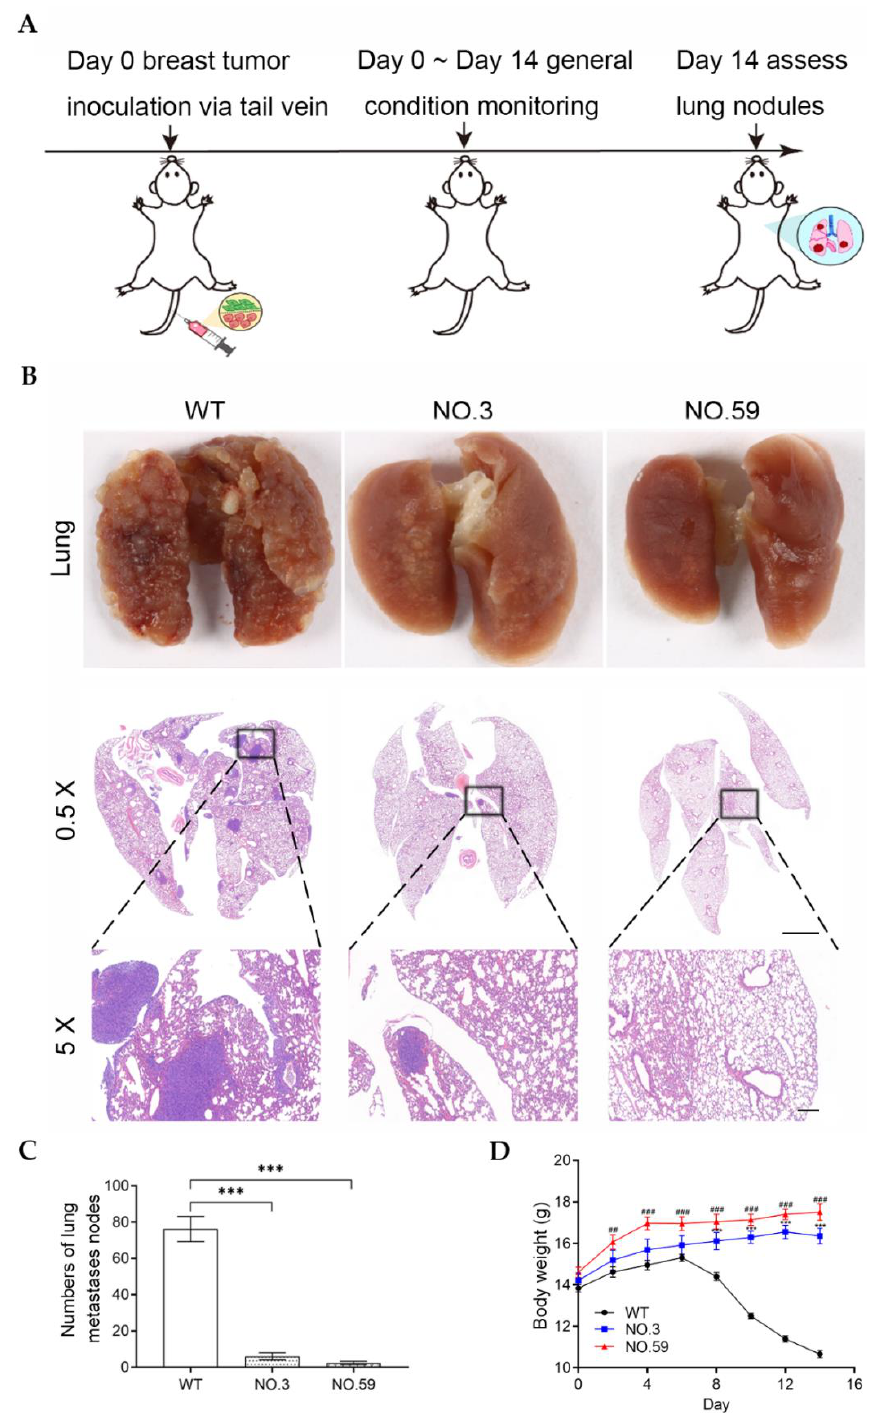
Figure 6. ( A ) Schematic illustration of the mouse experimental procedure for assessing the pulmonary metastasis capabilities via tail intravenous injection of the Cdh2-KO cells; ( B ) photographs of the lungs and H&E staining of the lung sections of mice injected with the wild-type or Cdh2-KO cell lines; magnification: 0.5×, Scale bar: 2 mm. Magnification: 0.5× , Scale bar: 200 μm. ( C ) The lung nodules were counted under an anatomical microscope. ( n = 5); ( D ) bodyweight change curves of the three groups of mice. ( n = 5). ‘*’: WT vs. No .3, ‘#’: WT vs. No.59. ## denotes p < 0.01, *** or ### p < 0.001.